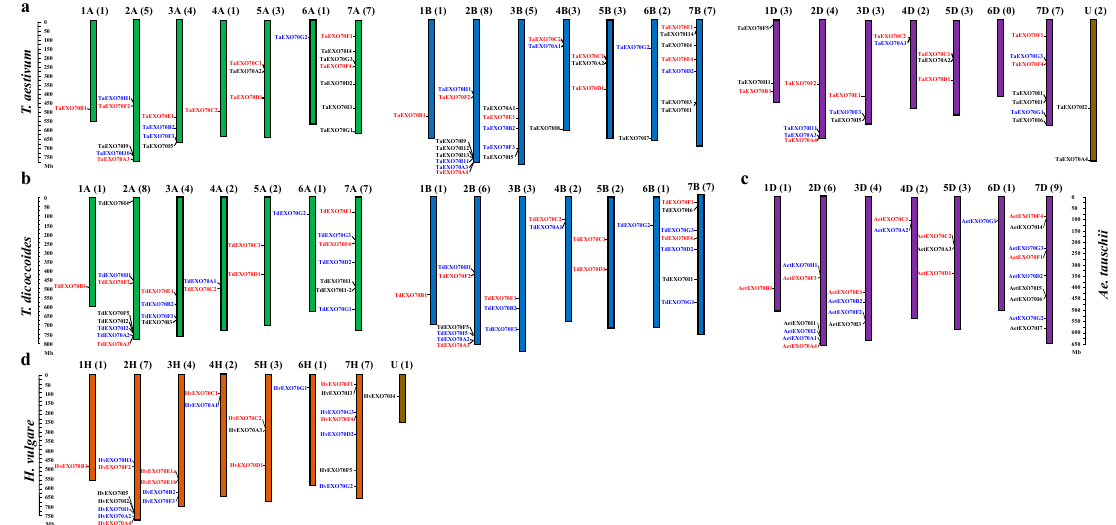
Figure 3. The chromosomal distribution of the EXO70 gene family in four Triticeae species. ( a – d ) represent T. aestivum , T. dicoccoides , A. tauschii and H. vulgare , respectively. Chromosome numbers are indicated at the top of each bar and the number in parentheses corresponds to the number of EXO70 genes present on that chromosome. The name of each gene is to the left of each chromosome. Gene names labeled with red, blue, or black indicate that they are conserved in four species, missing in one due to incomplete data, or missing in more than two, respectively.